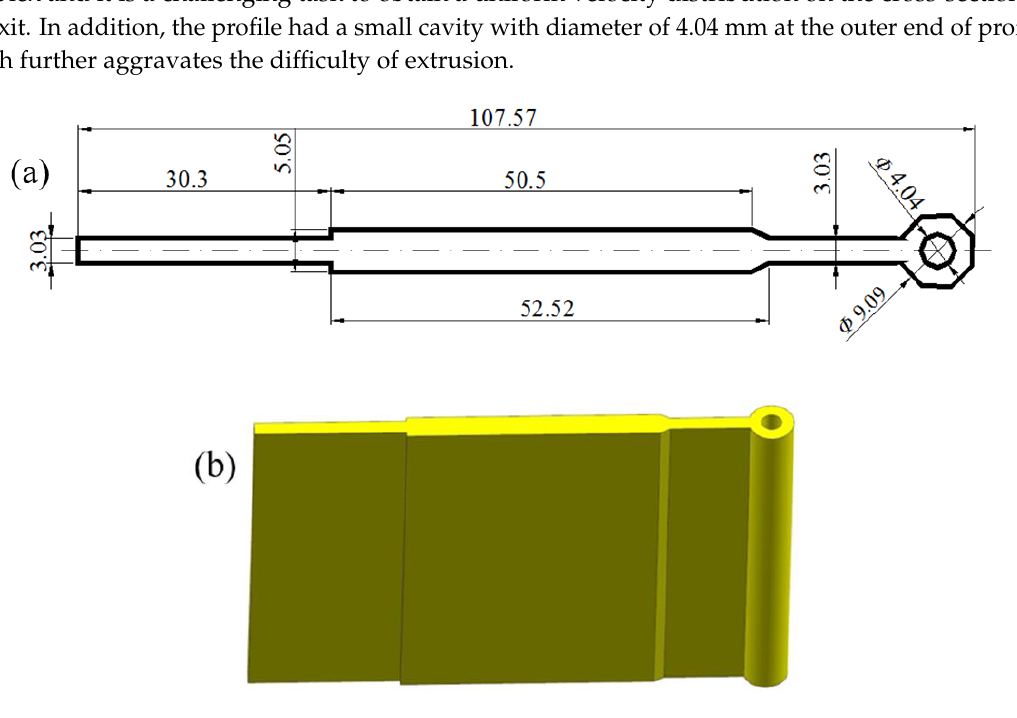
Figure 1. Geometric model of aluminum profile with small cavity: ( a ) 3D shape and ( b ) cross-section. (unit: mm).